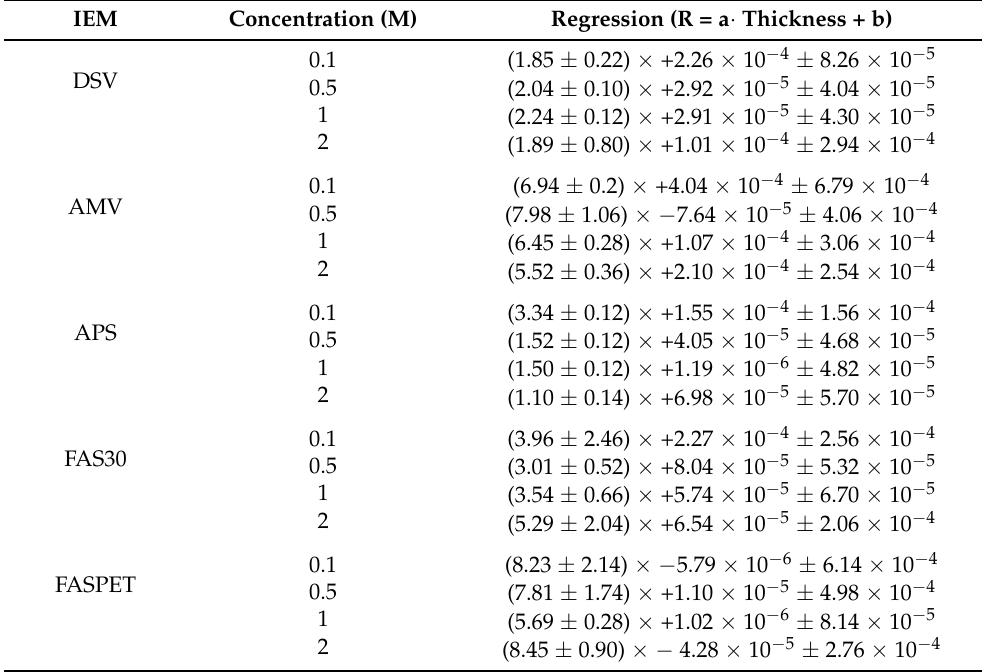
Table A1. AEMs at 298 K.